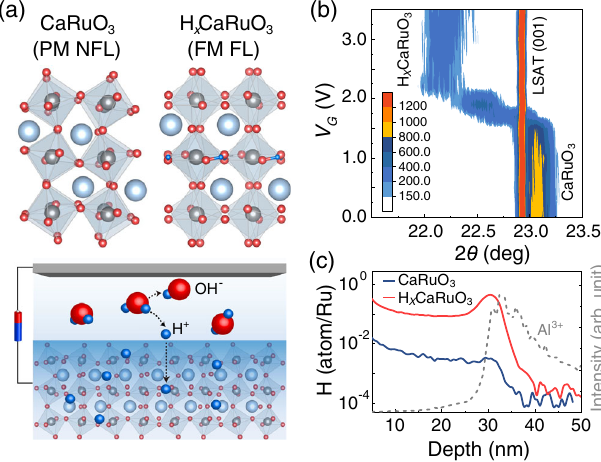
FIG. 1. Structural transformation of CaRuO 3 through ionic liquid gating induced protonation. (a) Schematic illustration of proton intercalated induced phase transformation in CaRuO 3 through ionic liquid gating (ILG). The upper panel shows a paramagnetic non-Fermi-liquid (PM NFL) metallic state in CaRuO 3 to ferromagnetic Fermi-liquid behavior (FM FL) in H CaRuO 3 ( x ¼ 0 . 5 ). The optimized crystalline structures were x obtained from DFT calculations. The lower panel shows a schematic for the protonation process during the ILG. (b) In situ XRD θ - 2 θ scans around (001) peak of CaRuO 3 as a function of gating voltage ( V ). The peak position shifts gradually toward G lower angle (from 23.07° to 22.17°) as the V increases, G corresponding to a distinct lattice expansion along out of plane for up to 4.1%. (c) Measured residual hydrogen concentration through ex situ SIMS on both pristine CaRuO 3 and proton intercalated H CaRuO 3 (gated at 3.5 V) samples. A referenced x Al 3 þ signature was also shown to highlight the interface position between film and